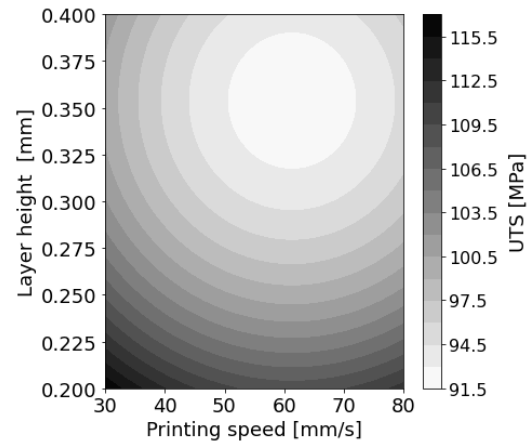
Figure A11. Contour plot for T bed and h according to the ML-based prediction model.